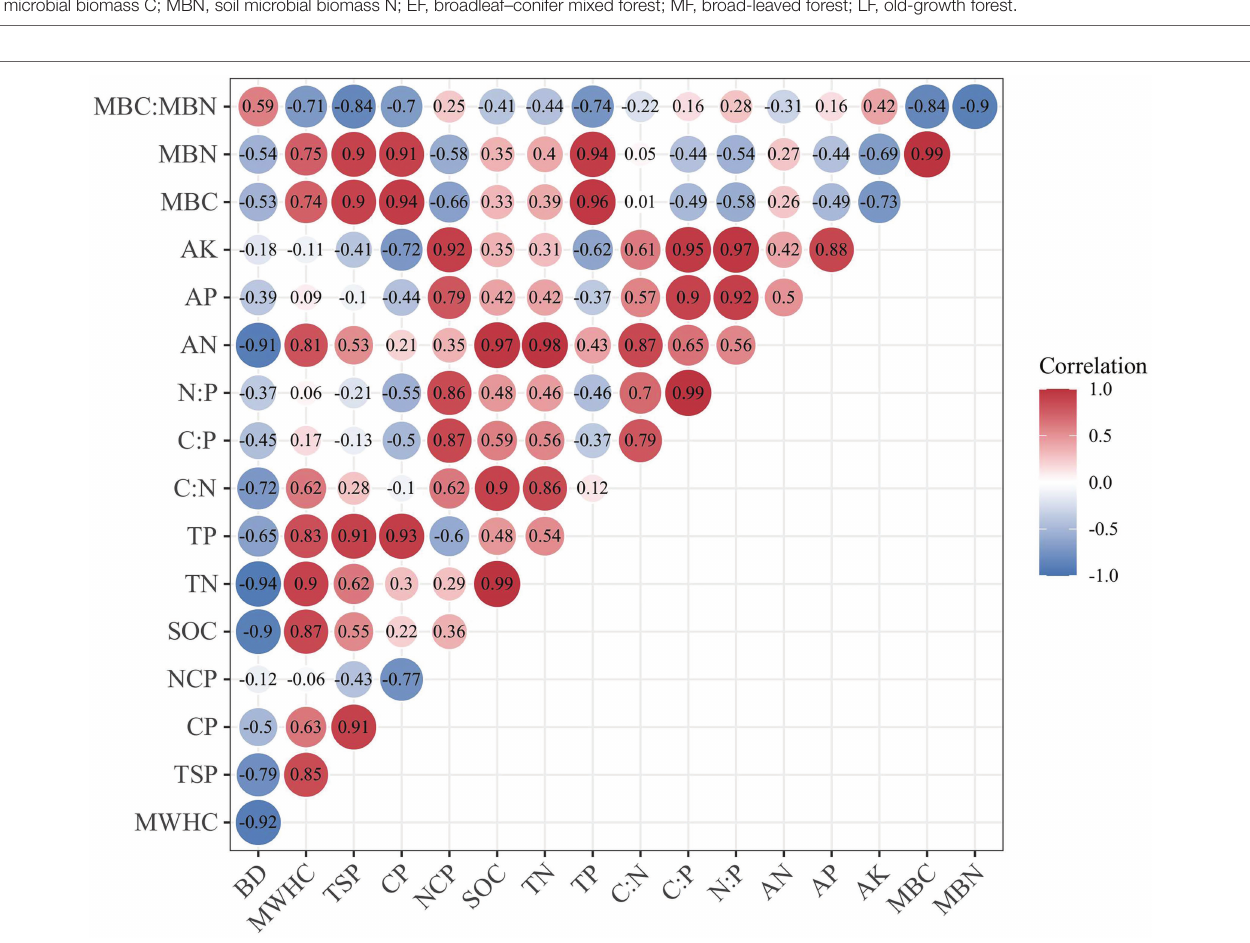
FIGURE 5 | The contents of MBC (A) , MBN (B) , and the ratio of MBC:MBN (C) in the 0–100 cm soil layer in different forests. Values are the means ± SE ( n = 6). Lowercase letters above the columns represent statistically significant differences among stand types for the same soil layer (Duncan’s tests, p < 0.05). MBC, soil